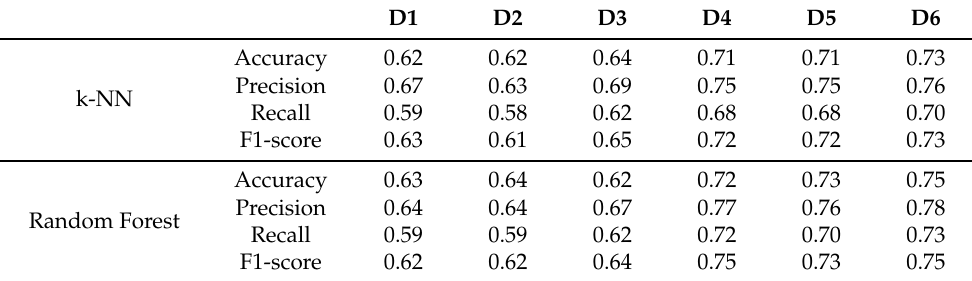
Table 3. Comparison of datasets for Accuracy, Precision, Recall, and F1-score.